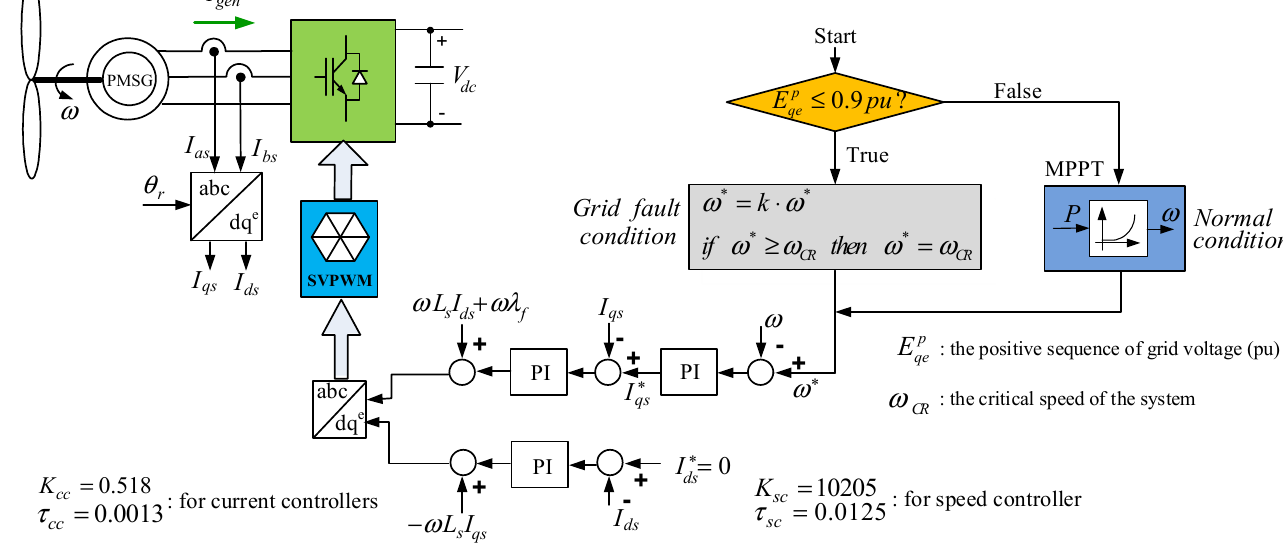
Figure 3. The control scheme of PMSG.